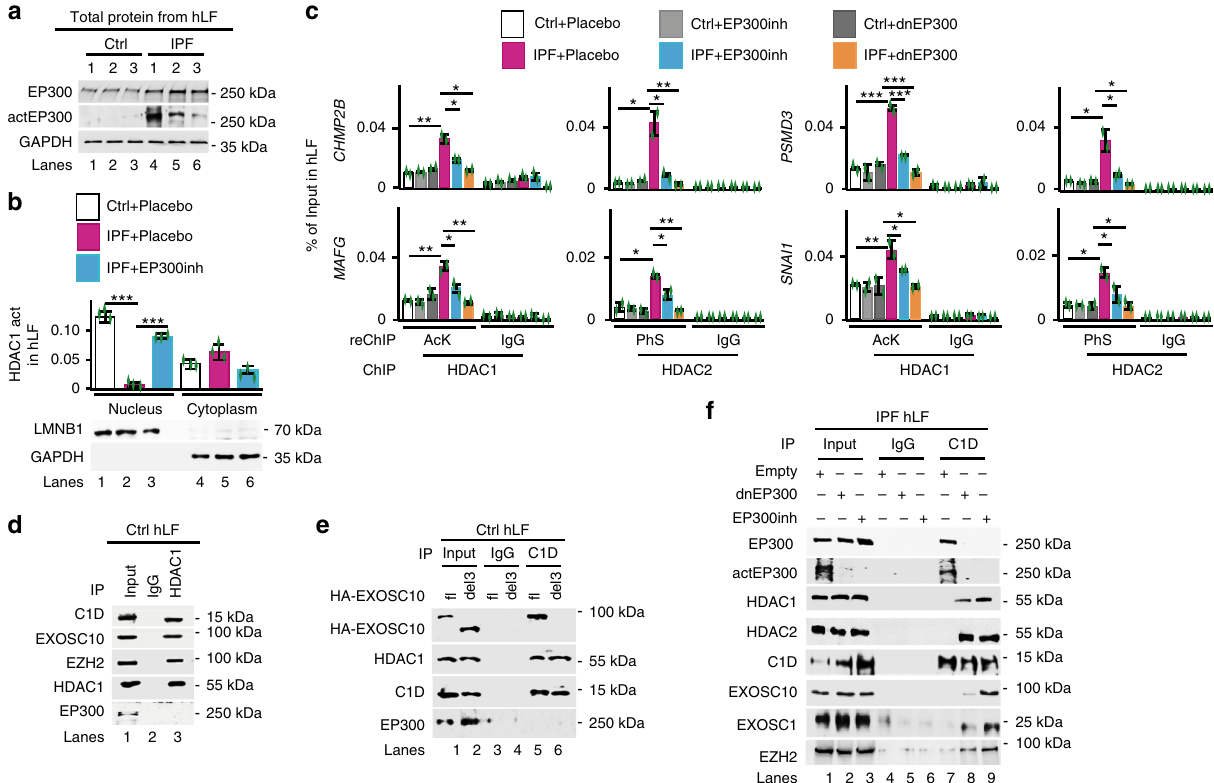
Fig. 6 Active EP300 inactivates HDAC1 in IPF. a WB using the indicated antibodies and whole-cell protein extracts from Ctrl and IPF lung fi broblasts (hLF) derived from three different donors each. ActEP300, active EP300. See Supplementary Fig. 6a – c. b Top: HDAC1-speci fi c activity assay using nuclear or cytosolic protein extracts from Ctrl or IPF hLF treated with placebo (vehicle solution) or 10 µ M EP300 inhibitor (EP300ihn, CBP30). Bottom: WB monitoring the quality of the fractions used in the HDAC1 activity assay. LMNB1, nuclear marker. GAPDH, cytosolic marker. See Supplementary Figs. 6d and 7a. c Sequential ChIP (ChIP – reChIP) analysis of representative MIRLET7D target promoters using HDAC1- or HDAC2-speci fi c antibodies, followed by AcK- or PhS-speci fi c antibodies, respectively, and chromatin isolated from Ctrl or IPF hLF after treatment with EP300inh or transfection of a dominant- negative EP300 (dnEP300) construct. IgG, immunoglobulin G (negative control). See Supplementary Fig. 7. d WB using the indicated antibodies after Co- IP assay using immunoglobulin G (IgG; negative control) or HDAC1-speci fi c antibodies to immunoprecipitate endogenous HDAC1 from nuclear protein extracts of Ctrl hLF. Input, 5% of IP starting material. e WB after Co-IP assay as in d using C1D-speci fi c antibodies to immunoprecipitate endogenous C1D from nuclear protein extracts of Ctrl hLF that were transfected with full-length ( fl ) or deletion mutant 3 (del3, lacking C1D interaction domain on amino acids 1 – 285) HA-tagged EXOSC10 constructs 25 . f WB after Co-IP assay as in d using C1D-speci fi c antibodies to immunoprecipitate endogenous C1D from nuclear protein extracts of IPF hLF that were either transfected with empty plasmid or with dnEP300 expression construct or treated with EP300inh as indicated. In all plots, data are shown as mean (SD) ( n = 3 biologically independent experiments in b ; n = 2 biologically independent experiments in c ); asterisks, P -values after unpaired t -test, two tailed, *** P < 0.001; ** P < 0.01; * P < 0.05. Source data are provided as a Source Data fi